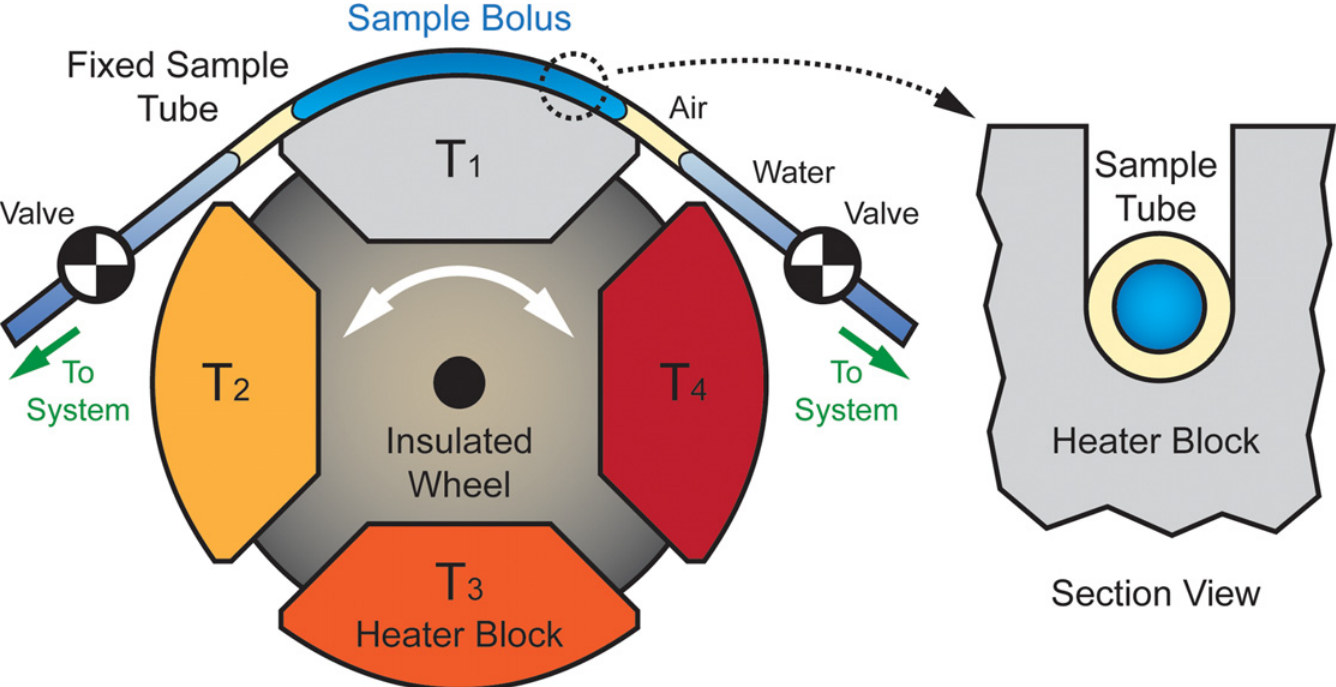
Fig 1. Functional schematic of the RZTC wheel. A fixed tube or capillary containing the sample to be cycled is held against temperature-controlled heater blocks, which are sequentially rotated into contact with the tube to produce the desired temperature cycling. Blocks are arranged around the wheel in order of increasing temperature. The tube rests in a groove on the outer surface of the heater block (right) and is tensioned against the block to maximize thermal coupling and sample ramp